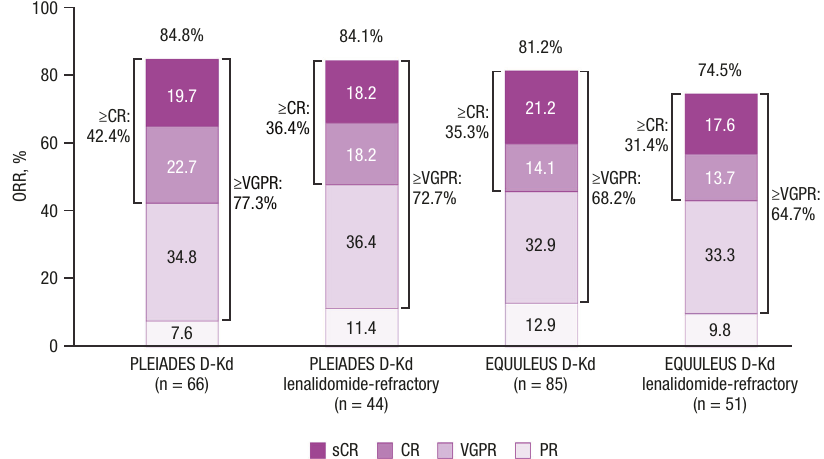
Fig. 1 Response rates in all patients and lenalidomide-refractory patients treated with D-Kd in PLEIADES or EQUULEUS. Data were shown for the all-treated population. Note: Due to rounding, percentages may not add up to the total percentage for each category. CR complete response, D-Kd daratumumab/car fi lzomib/dexamethasone, ORR overall response rate, PR partial response, sCR stringent complete response, VGPR very good partial response. 6 (60.0%) patients who received a single fi rst dose and 31 (41.3%) dysfunction. In EQUULEUS, 9 (10.6%) patients had grade 3/4 cardiac who received a split fi rst dose had IRRs with daratumumab IV. TEAEs, including sinus tachycardia, cardiac failure, systolic dysfunc- Most IRRs were mild (2 patients had grade 3/4 IRRs) and occurred tion ( n = 2 each) and atrial fi brillation, congestive cardiomyopathy, during the fi rst infusion. Five (50.0%) patients experienced IRRs left ventricular failure, myocardial ischemia, and myocarditis ( n = 1 during Cycle 1, Day 1 with a single fi rst daratumumab dose; 27 each). In both studies, the median left ventricular ejection fraction (36.0%) experienced IRRs during Cycle 1, Day 1 with a split fi rst did not notably change over time from baseline. Additional details daratumumab dose. are included in Supplementary Information. In PLEIADES (median [range] follow-up, 12.4 [0.2 – 20.6] months), Three (4.5%) patients had infusion-related reactions (IRRs) with ORR was 84.8% in the all-treated population and 84.1% in DARA SC in PLEIADES; two had grade 3 IRRs. All patients with IRRs lenalidomide-refractory patients (Fig. 1). ORR was 75.0% (12/16) experienced them on the fi rst administration; the median (range) and 82.1% (23/28) in patients with high and standard cytogenetic time to IRR onset was 65 (4 – 75) min. Local injection-site reactions risk, respectively. The median duration of response was not occurred in 7 (10.6%) patients; all were grade 1/2. In EQUULEUS, Blood Cancer Journal (2023)